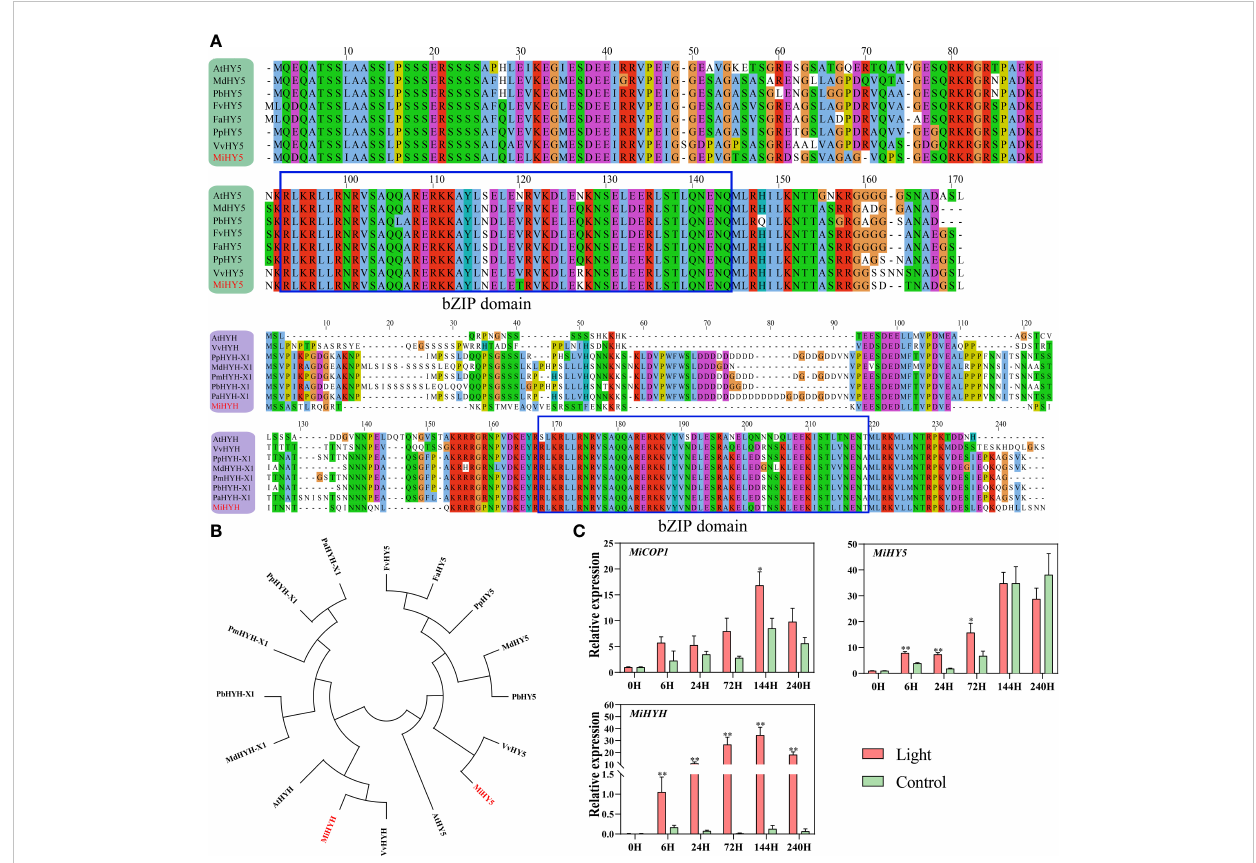
FIGURE 5 (A) Multiple sequence alignment of HY5 and HYH proteins in mango and other plant species. The bZIP domain is boxed. The mango proteins are highlighted in red. (B) Phylogenetic tree derived from amino acid sequences of HY5 and HYH in mango and other plant species. The mango proteins are highlighted in red. All sequences were retrieved from NCBI database with accessions as follows: Arabidopsis thaliana AtHY5 (O24646.1) and AtHYH (OAP05786.1); Malus domestica MdHY5 (NP_001280752.1) and MdHYH-X1 (XP_008369576.1); Pyrus x bretschneideri PbHY5 (XP_009355719.1) and PbHYH-X1 (XP_009353456.1); Fragaria vesca subsp. Vesca FvHY5 (XP_004291469.1); Fragaria x ananassa FaHY5 (AKG58815.1); Prunus persica PpHY5 (XP_020411091.1) and PpHYH-X1 (XP_020409867.1); Vitis vinifera VvHY5 (XP_010648648.1) and